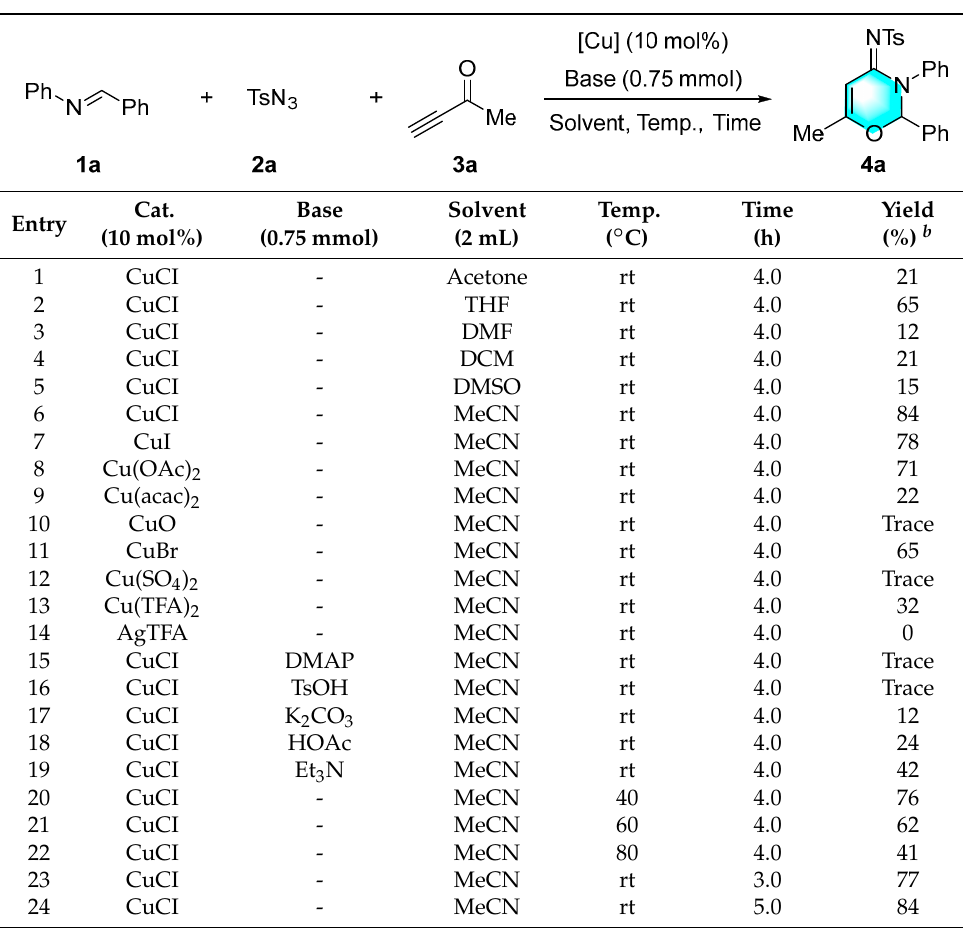
Table 1. Optimization of conditions a .